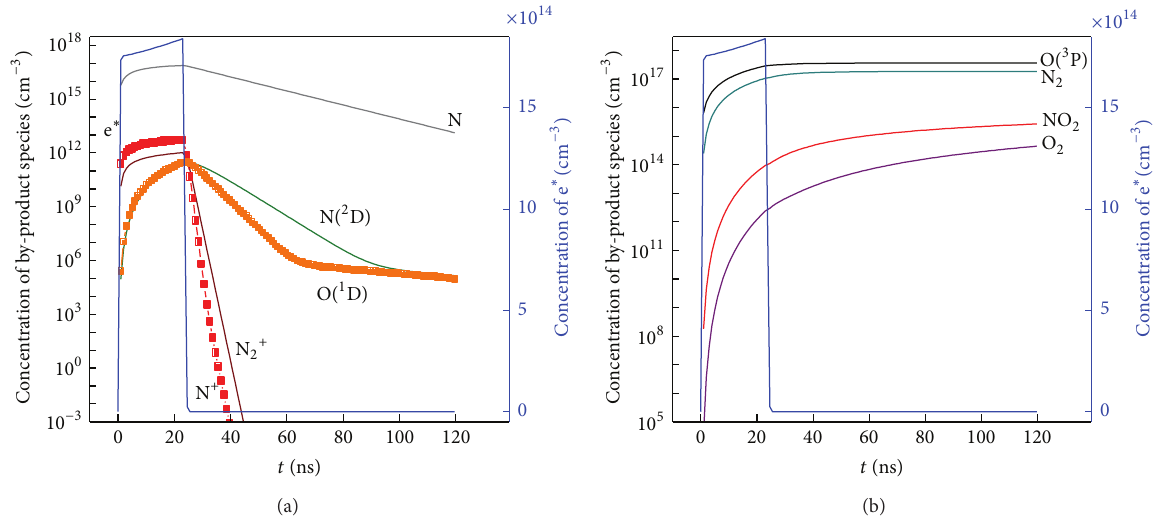
Figure 8: Concentration variance of by-product species and electrons versus time. (a) N + , N 2 + , O( 1 D), N( 2 D), N, and electron; (b) O( 3 P), N 2 , O 2 , NO 2 , and electron.